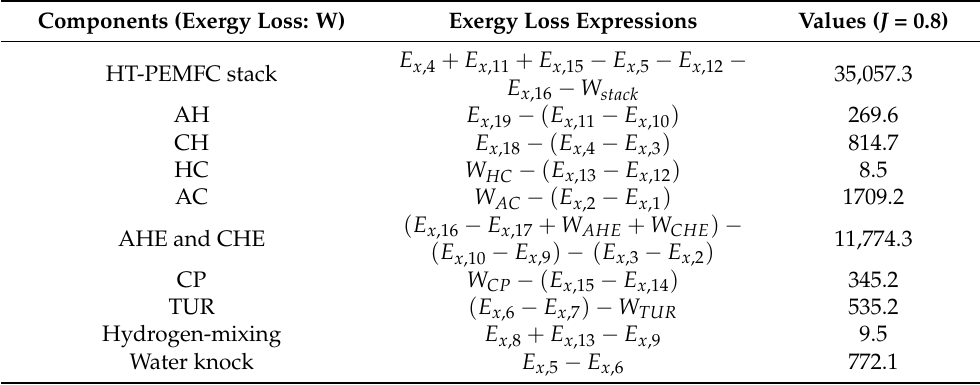
Figure 4. Temperature, pressure and mass flow exergy distribution in the HT-PEMFC system at current density J = 0.8 A cm 2 . Table 3. Exergy loss expressions for each component and exergy loss distribution at current density 𝐽 = 0.8 A cm 2 .